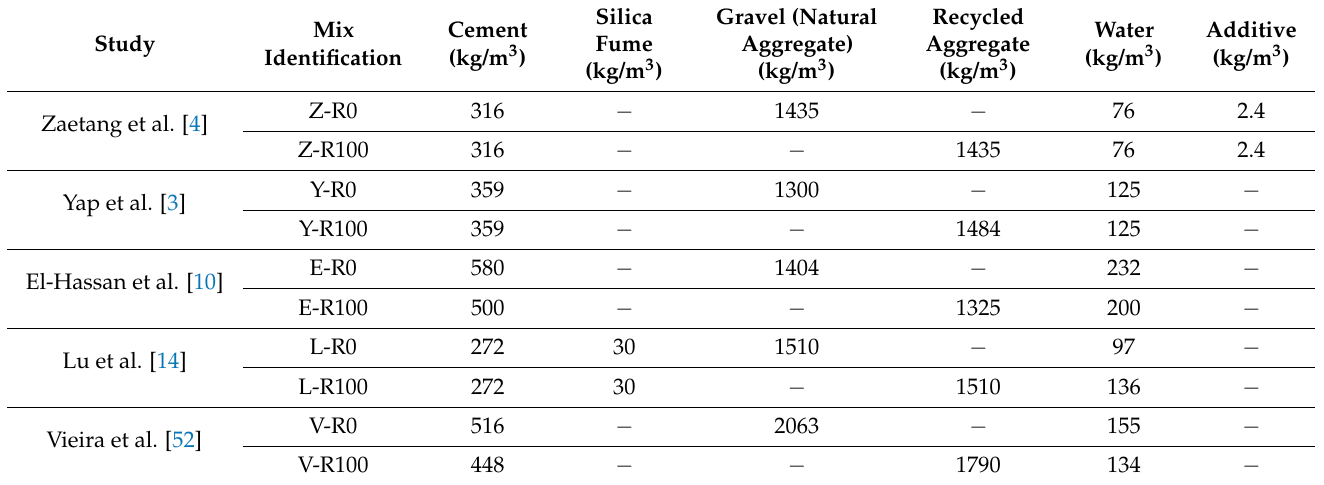
Table 5. Proportions of the mixes used to compare the analysed